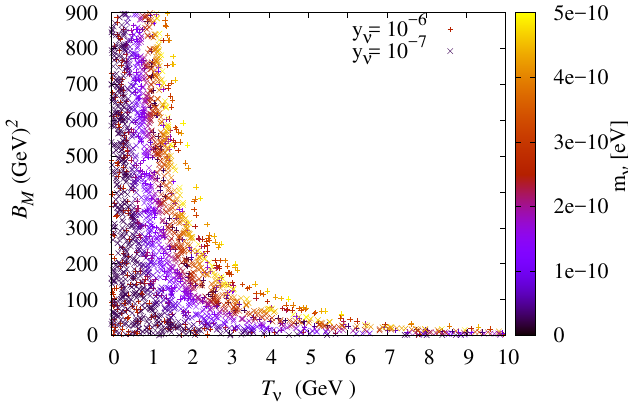
Figure 7 . Allowed regions of B M and T (cid:23) plane for M 1 = 1 : 5 TeV, M 2 = 1 : 8 TeV and gaugino fraction (cid:24) O (10 (cid:0) 2 ). The colored palette denotes the mass of the heaviest neutrino.